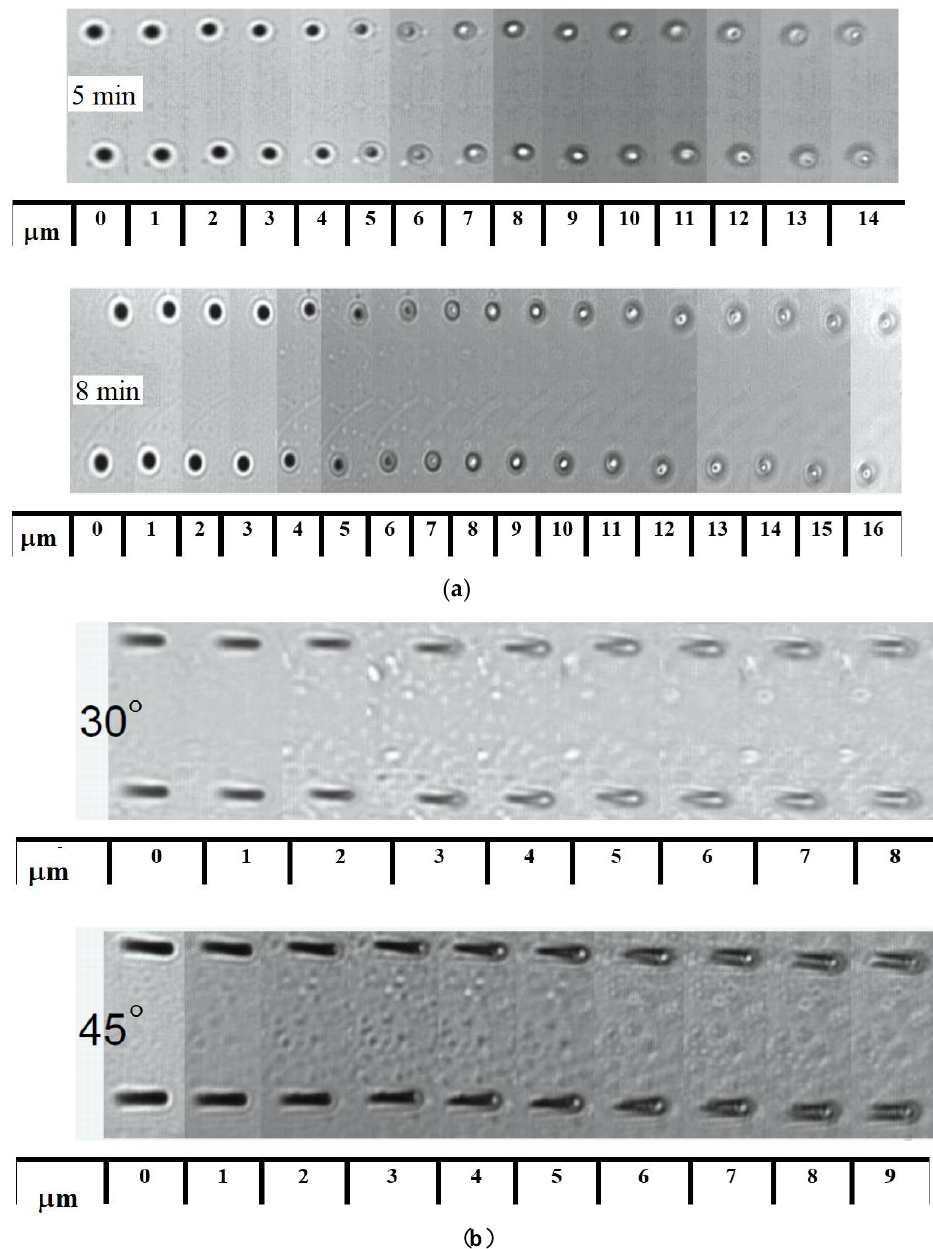
Figure 1. The shape of the 132 Xe 26+ ion tracks after etching in 40% HF for different etching depths (indicated under the images): ( a ) vertical entry, ion energy E = 65 – 68 MeV (the etching duration is given); ( b ) entry at 30° and 45° to the normal to the glass surface, ion energy E = 160 MeV; the etching duration is 5 min (No color).